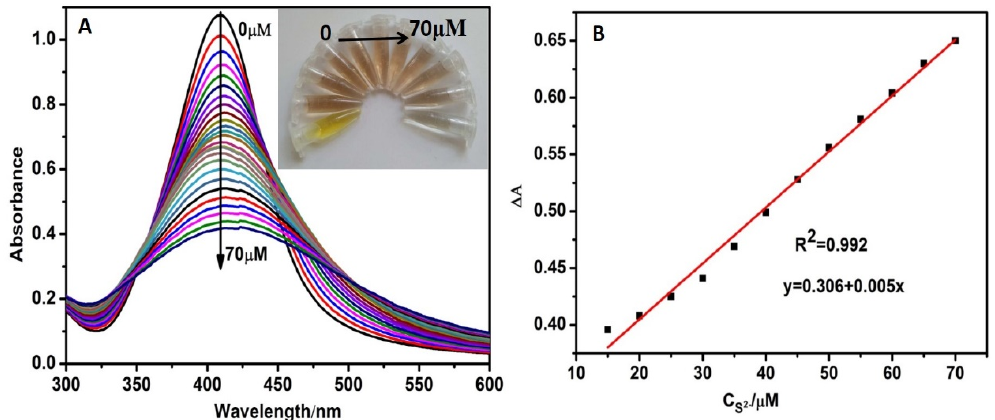
Figure 9. ( A ) UV–VIS spectroscopy of CMS/AgNPs colloidal solution with different concentration of S 2 − , and ( B ) the linear relative absorption intensity ∆ A over the concentration of S 2 − is within the range S 2 − , and ( B ) the linear relative absorption intensity Δ A over the concentration of S 2 − is within the range of 15–70 µ of 15–70 μ M.